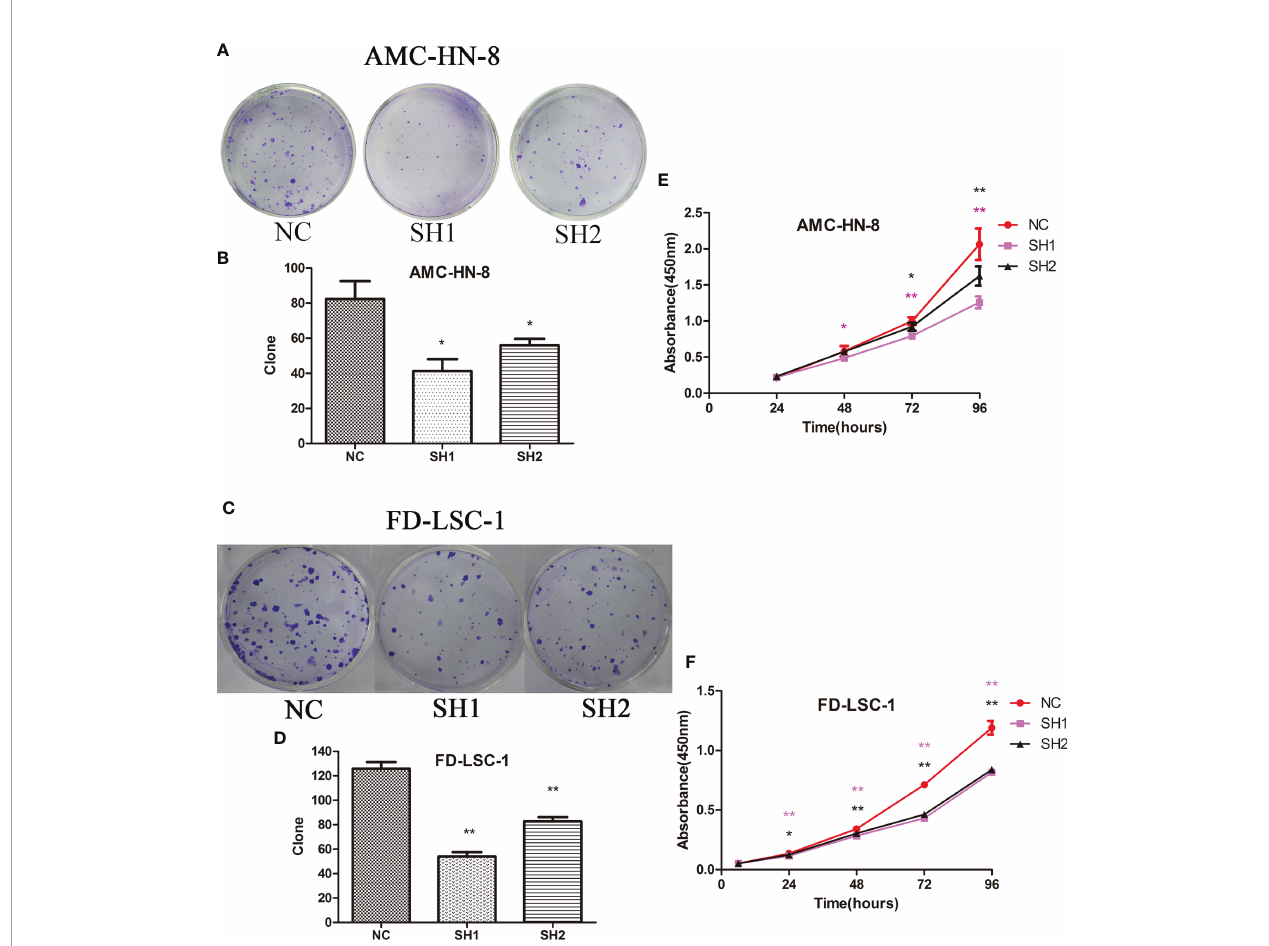
FIGURE 2 | Colony formation assay and CCK-8 assay of DIAPH1 knockdown (SH) cells and the negative control (NC) cells. (A, C) Representative graphs of colony formation of the indicated cells. (B, D) Comparison of the clonogenicity of the indicated cells between DIAPH1 SH1, SH2 and NC groups. (E, F) Cell proliferation was assessed in DIAPH1 SH1, SH2 and NC groups using CCK8 assays ∗ p < 0 05, ∗∗ p < 0